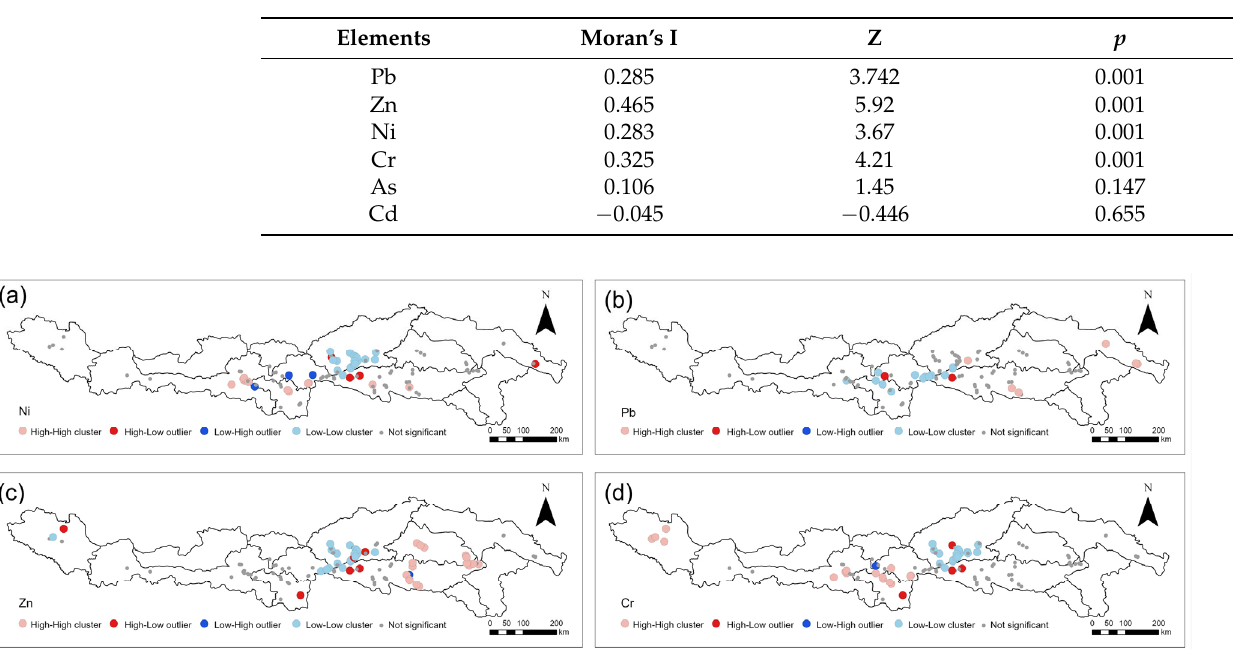
Table 3. Moran’s I of soil heavy metal content.